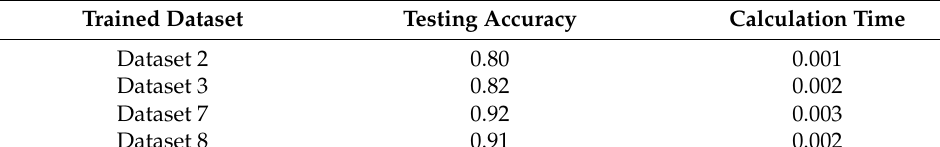
Figure 8. Overfitting small data for RGB dataset-2. Table 2. Comparison with other datasets for testing accuracy and calculation time.